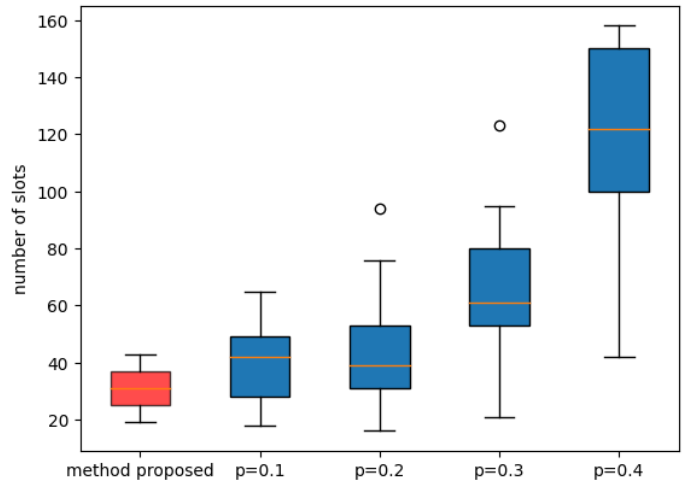
Figure 14. Time comparison to send a message packet to the base station with the proposed method and the classic Aloha protocol using different speaking probabilities p